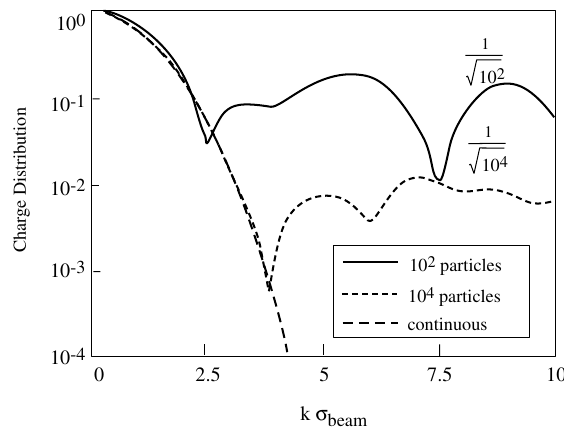
FIG. 1. Spectrum of charge distribution for an analytical continuous distribution and for a distribution sampled with 10 2 and 10 4 macroparticles. The charge distribution is normal- ized to